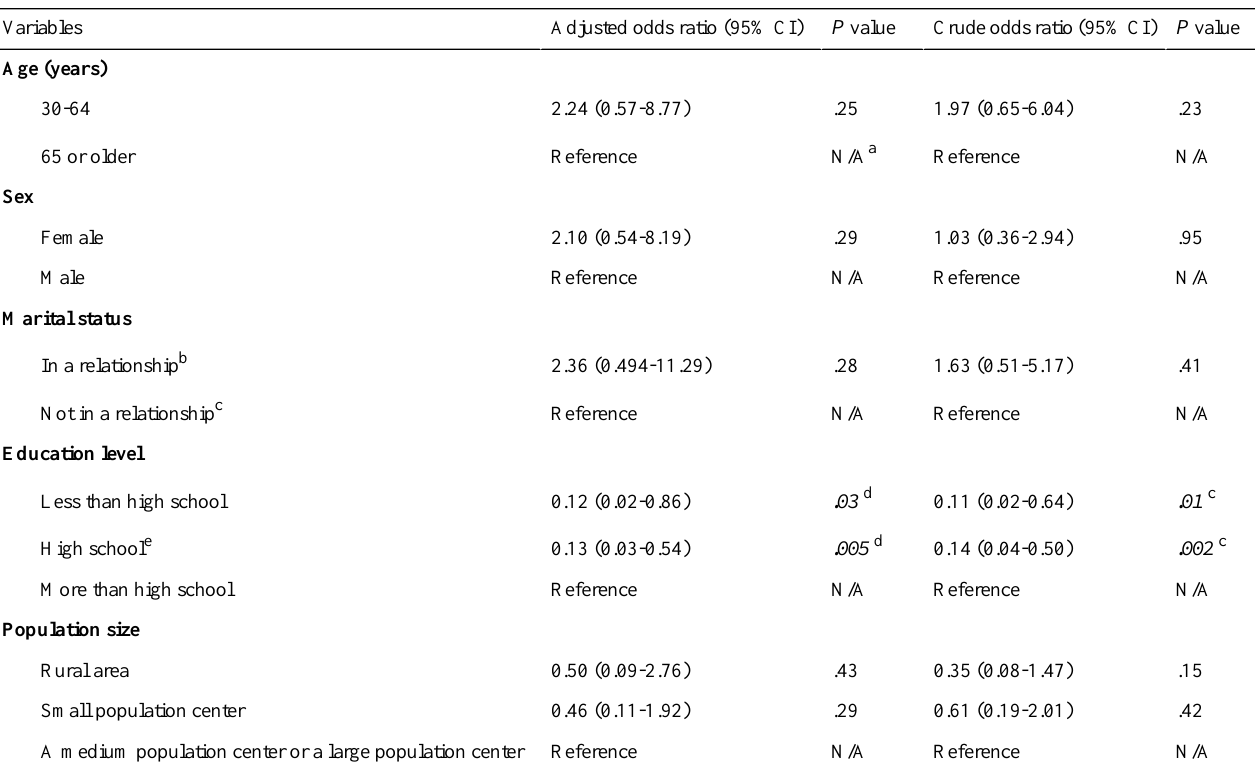
Table 3. Logistic regression predicting the likelihood of smartphone